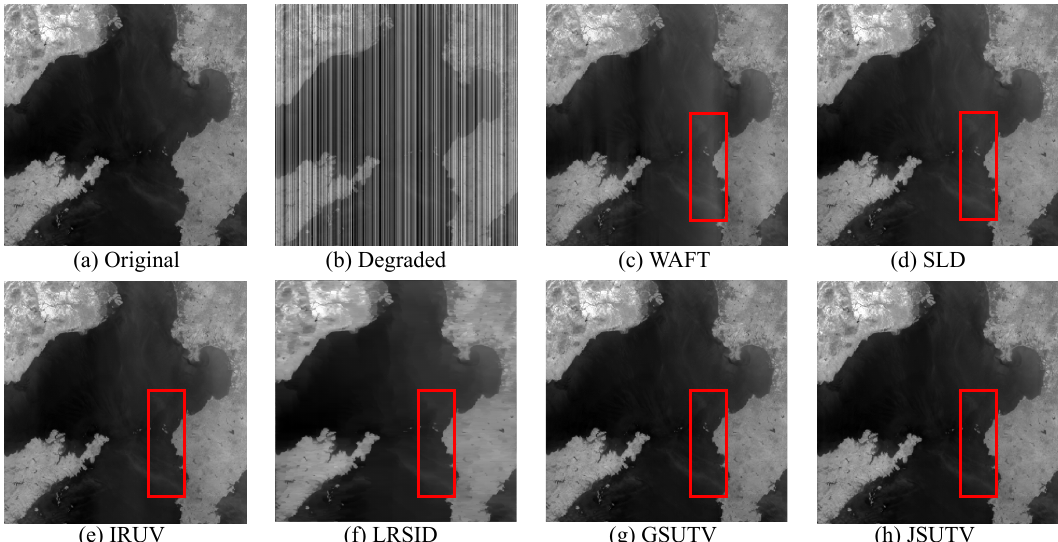
Figure 4. Simulated destriping results of Case 9. ( a ) Original image; ( b ) degraded image; destriping images of: ( c ) WAFT; ( d ) SLD; ( e ) IRUV; ( f ) LRSID; ( g ) GSUTV; ( h ) JSUTV.